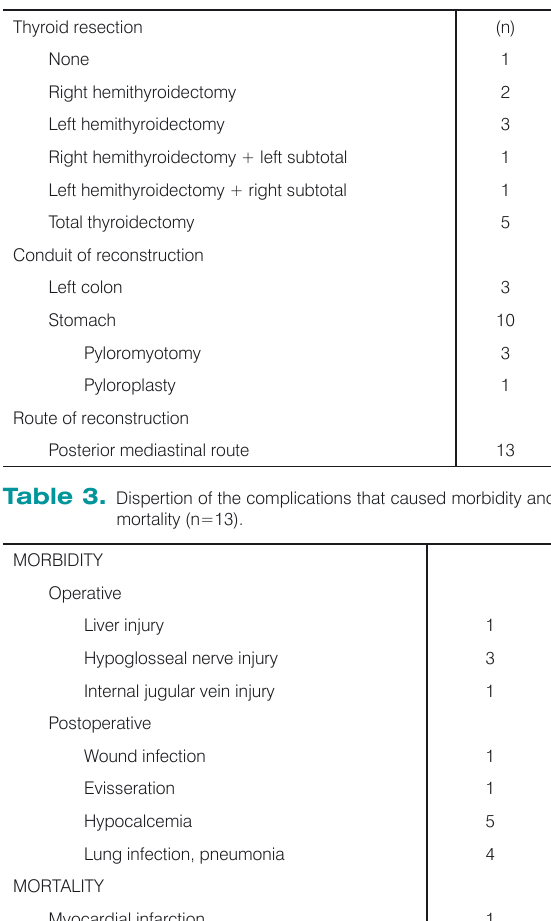
Table 2. Properties of the applied surgical procedures (n=13).